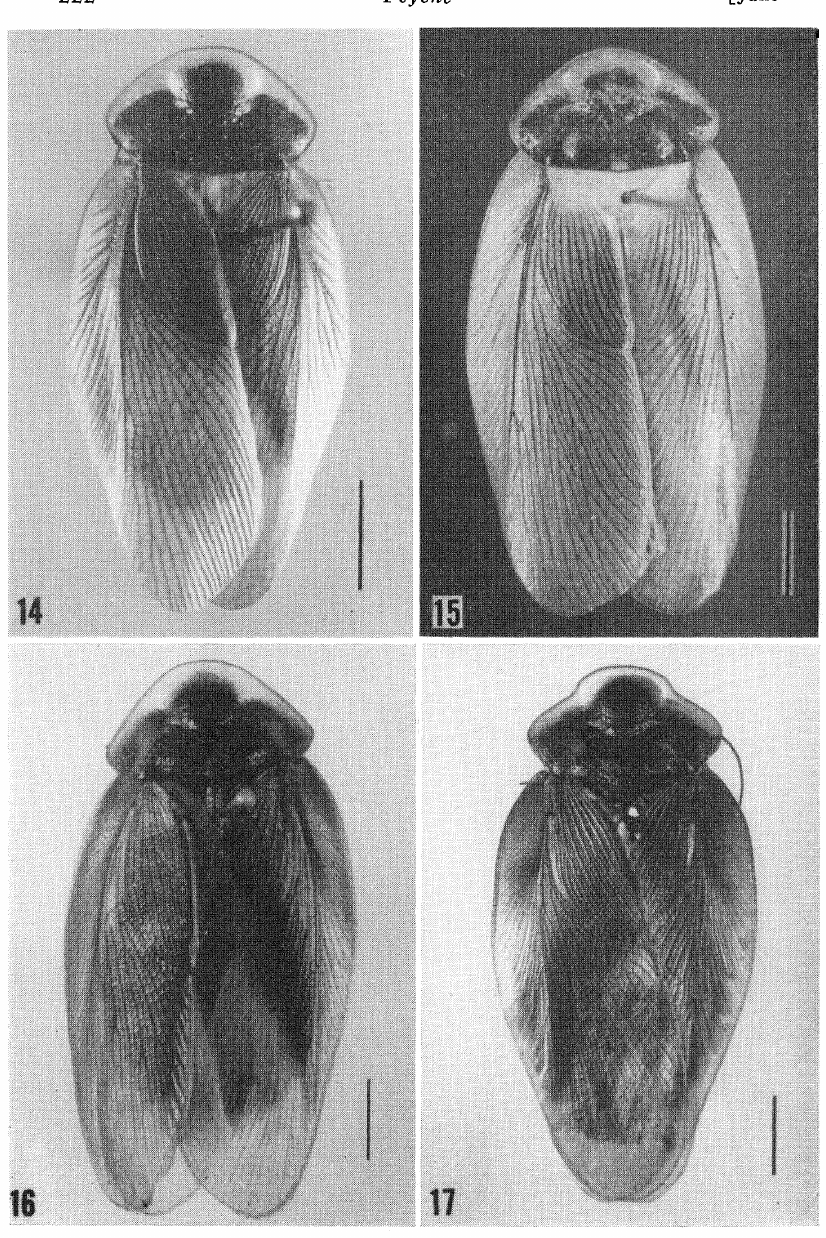
Figs. 14-17. 14. (101 ANSP). Phortioeca nlmbata (Burm.). St. Jean du Maroni, French Guiana. 15. (100 ANSP). Phortioeca aolinari Hebard. Paratype. Villaviceneio, Colombia. 16. (2 CUZM). Phort’oeca errucosa (Sauss.). Riaeho del Pra. (det. Prineis). 17. (5 BMNH). Pl, or,ioeca maximiliani (Sauss.). Cahabon, Vera Paz, Mexico. (scale